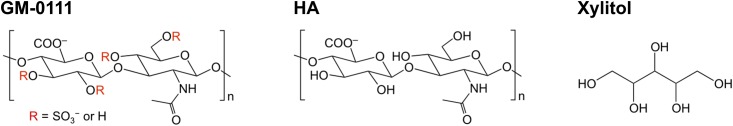
Chemical structures of GM-0111 (A), HA (B), and xylitol (C).GM-0111 shares the same disaccharide backbone with that of HA.